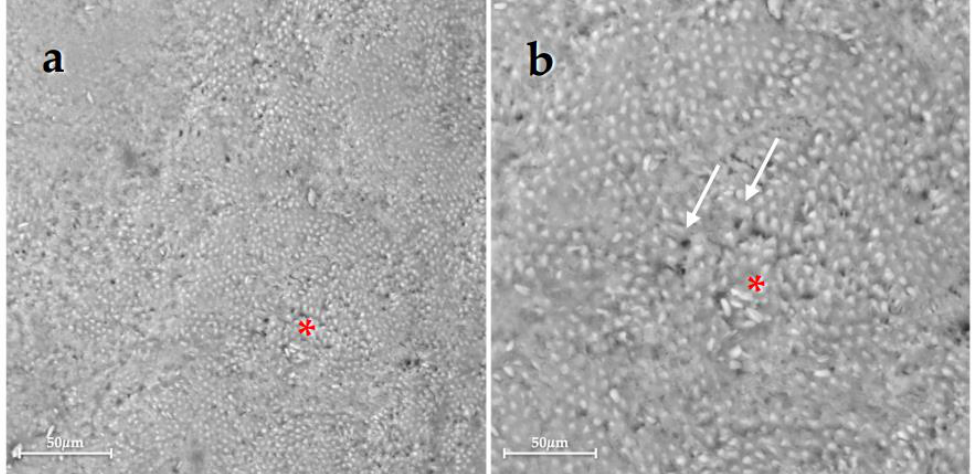
Figure 3. Scanning electron micrographs of Group 3 ( a ) at 500 × magnification, showing an almost complete surface morphology reorganization with some material residues (red asterisks); and ( b ) at 1000 × magnification, showing the presence of slightly dissoluted areas (white arrows).